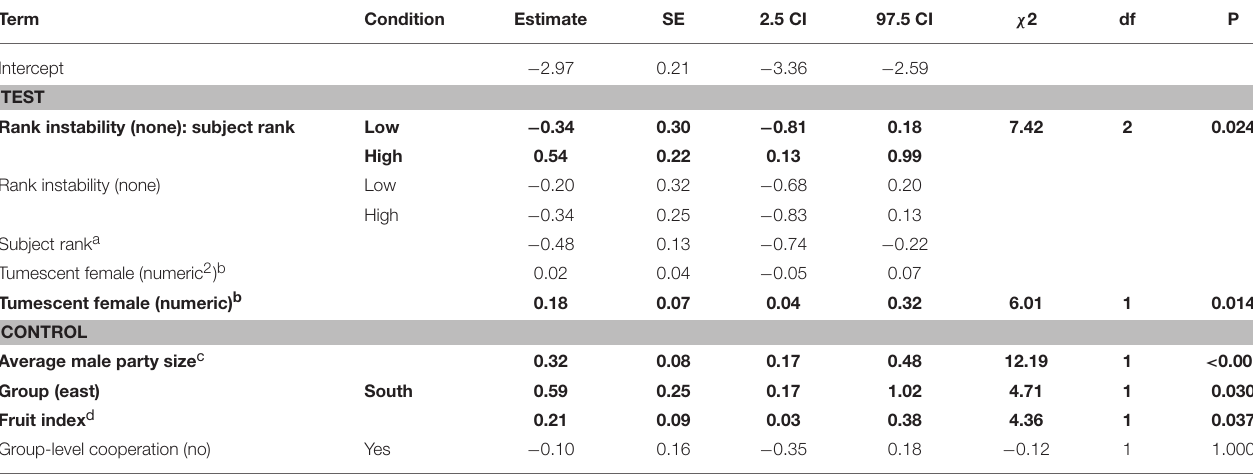
TABLE 5 | Effect of rank instability, subject rank and number of fully tumescent parous females (tumescent female) present on the number of aggressions males received (model 2.2). Term Condition